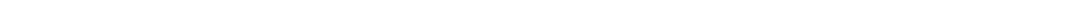
(see fi gure on previous page) Fig. 1 GH induces TGF- β /SMAD pathway in podocytes. A , B qRT-PCR analysis showing the expression of TGF- β 1 in human podocytes treated with or without GH in concentration (100 – 500 ng/ml) and time- (up to 48 h) dependent manner. mRNA levels were normalized to β -actin and presented as fold change on the y -axis. Mean ± SD. ( n = 5). **** p < 0.0001 by one-way ANOVA post hoc Dunnett test. C , D Immunoblotting analysis for indicated genes from podocytes treated with GH in concentration (100 – 500 ng/ml) and time- (up to 48 h) dependent manner. ( n = 3). E Immuno fl uorescence analysis for TGF- β 1 (purple color) and counterstained with DAPI [4 ′ ,6-diamidino-2-phenylindole (blue color)] in podocytes treated with or without GH (500 ng/ml, 48 h). Scale bar = 50 μ m, magni fi cation ×500. F , G Estimation of TGF- β 1 in conditioned media (CM) from podocytes treated with GH in concentration (100 – 500 ng/ml) and time- (up to 48 h) dependent manner. Mean ± SD. ( n = 5). H , I SMAD4 luciferase activity in podocytes treated with GH in concentration (100 – 500 ng/ml) and time- (up to 48 h) dependent manner. Mean ± SD. ( n = 6). F – I **** p < 0.0001 by one-way ANOVA post hoc Dunnet test. J , K qRT-PCR and immunoblotting analysis show TGFBR1 and TGF- β 1 in mice podocytes treated with or without GH (1.5 mg/kg b.w). Mean ± SD. ( n = 3). **** p < 0.0001 by Student ’ s t test. Each data point represents the average value of mice from each group. n = 6. L Representative images for TGFBR1 and TGF- β 1 expression assessed by 3,3 ′ -diaminobenzidine (DAB) staining in mice glomerular sections treated with GH. Scale bar = 100 μ m, magni fi cation ×200. ( n = 3). Quanti fi cation of TGF- β R1 and TGF- β 1 staining area in the glomerulus (right panel) represented as a dot plot. Mean ± SD. ( n = 6). **** p < 0.0001 by Student ’ s t test. M Quanti fi cation of TGF- β 1 in urine from mice administered with GH. Mean ± SD. ( n = 6). **** p < 0.0001 by Student ’ s t test. Each data point represents the average value of a single mouse from each